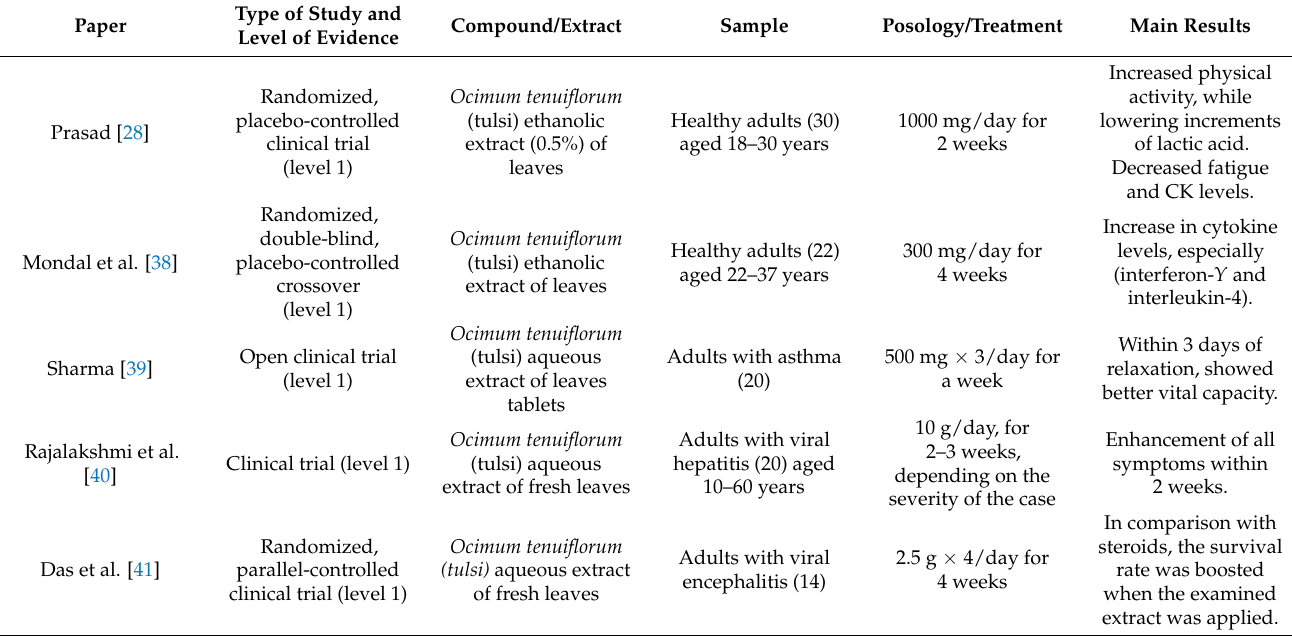
Table 3. Immunomodulatory effects of tulsi basil ( Ocimum tenuiflorum ) extracts in the laboratory in human clinical